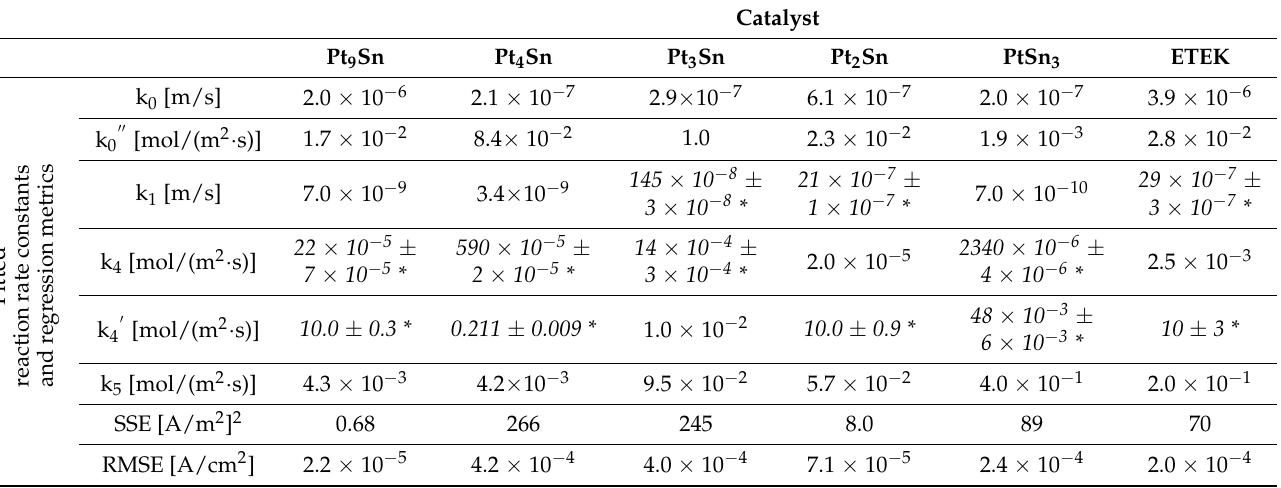
Figure 2 presents the fitted surface coverage fraction distributions for each catalyst. The lines in the graph do not represent a model fit and are visual guides only. Surface coverage fractions were fitted for each adsorbed species at each overpotential value from the experimental data